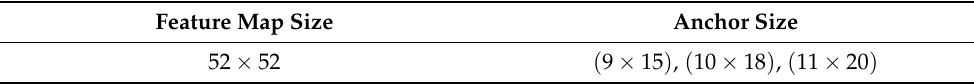
Table 2. New anchors obtained on our training